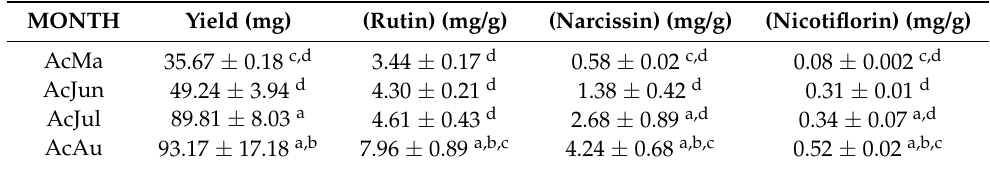
The data are expressed as the mean ± SEM. n = 3 analyzed samples. a p < 0.05 vs. AcMa; b p < 0.05 vs. AcJun